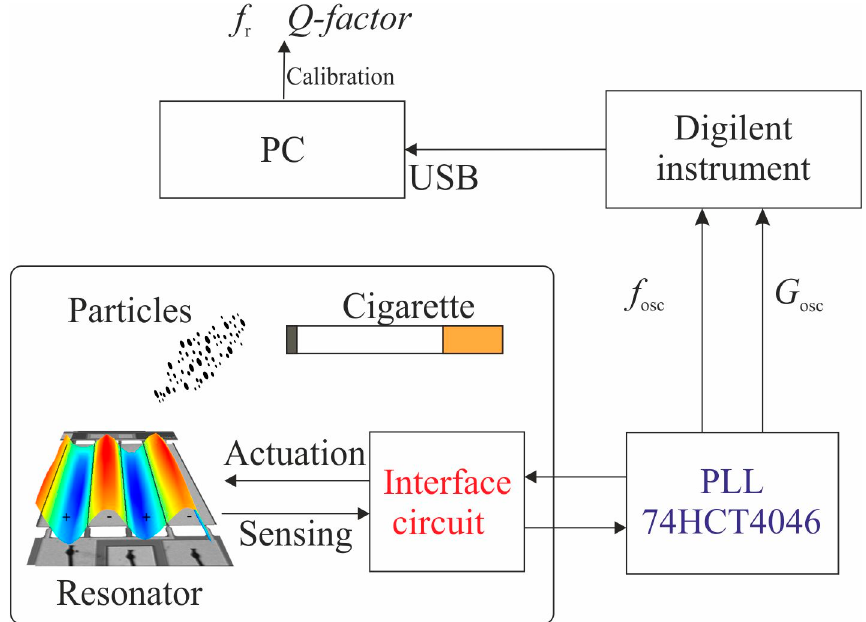
Figure 8. Schematic of the closed-loop setup with the PLL 74HCT4046.